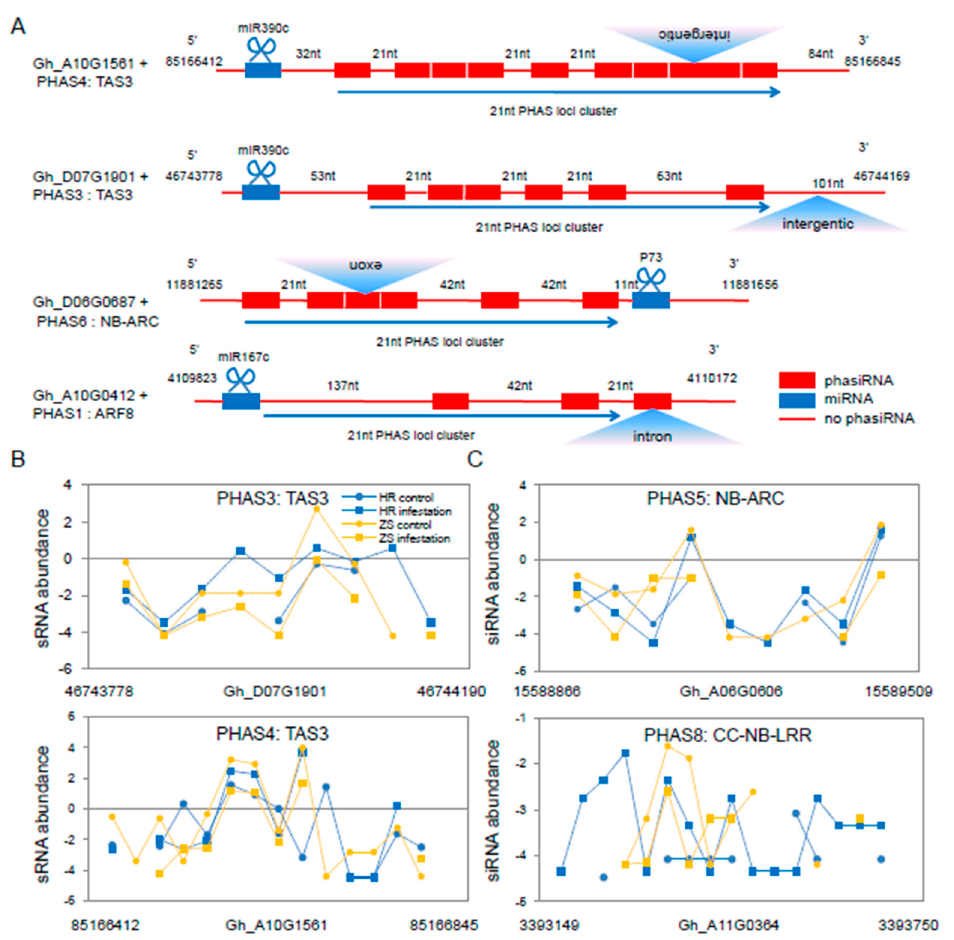
Figure 5. Characteristics of select siRNAs and various PHAS loci in cotton following whitefly infestation. ( A ) Schematic diagram of the 21-nt siRNAs generated from the PHAS loci in cotton following whitefly infestation. The structures of three typical PHAS genes are showed with phasiRNAs denoted by red boxes (indicating different siRNA sequences). Blue boxes represent the miRNA cleavage sites and red lines indicate non- PHAS loci. Blue triangles represent gene locations. ( B ) The expression profile of siRNAs in TAS3 . ( C ) The PHAS siRNA derived from the NB-LRR disease-resistant protein sequence.